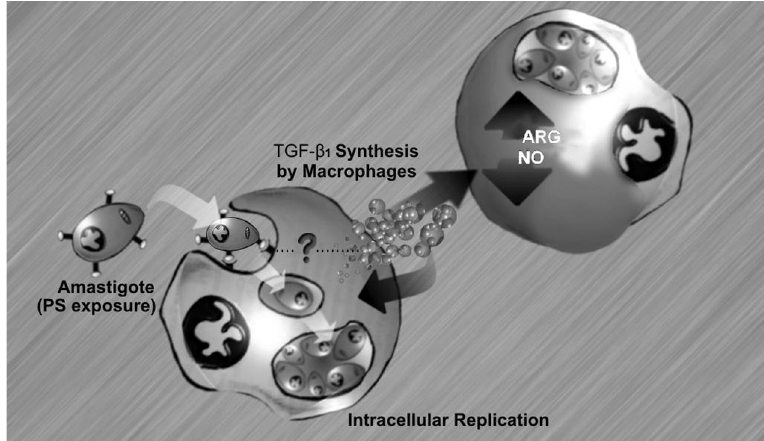
Figure 1. Macrophage modulation by amastigotes exposing phosphatidylserine. ARG = arginase activity; NO = nitric oxide; PS = phosphatidylserine; TGF-ß 1 = transforming growth factor ß 1